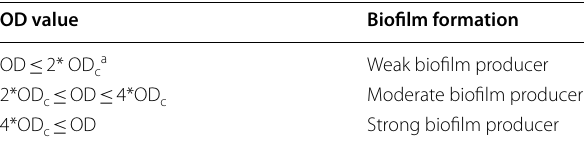
tested isolates according to their biofilm formation